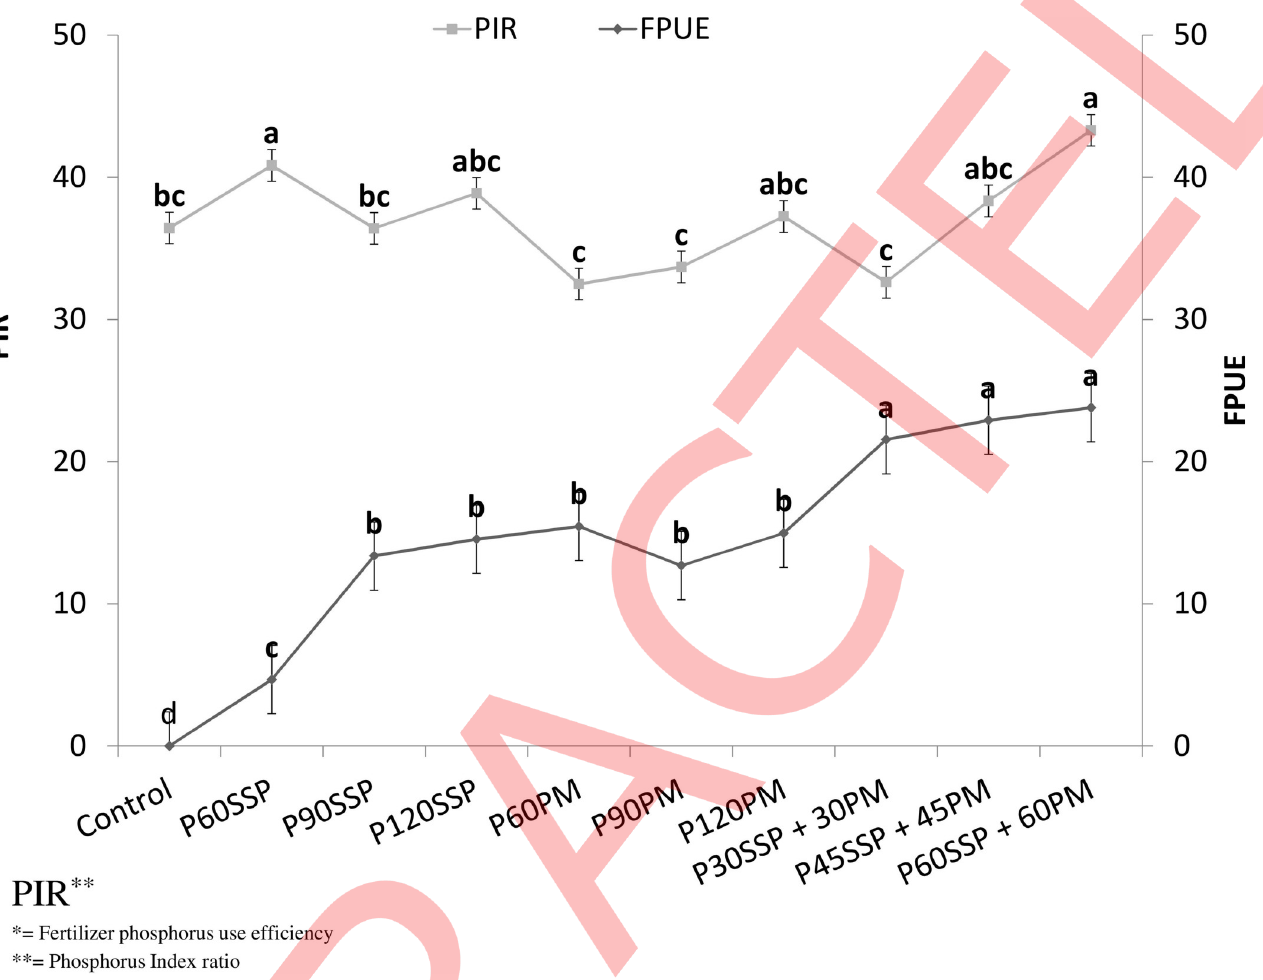
Fig 3. Effect of various organic and inorganic P nutrients sources on FPUE � and PIR �